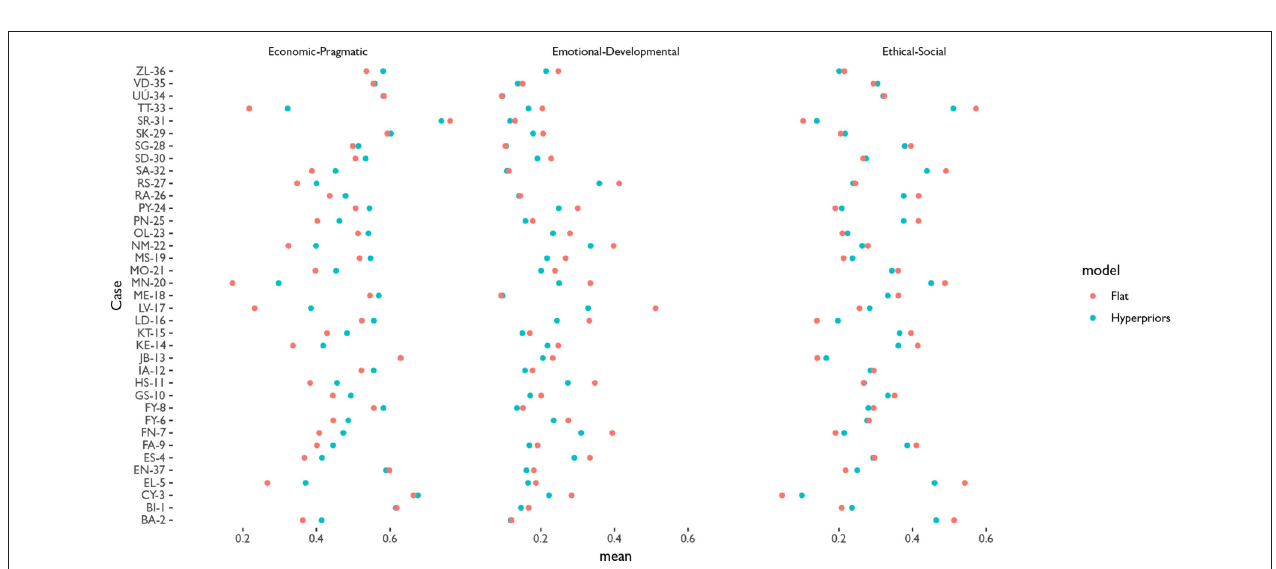
FIGURE 6 | Comparison between the estimated latent configurations of values between the model with flat priors and the model with hyperpriors for each axis of values.